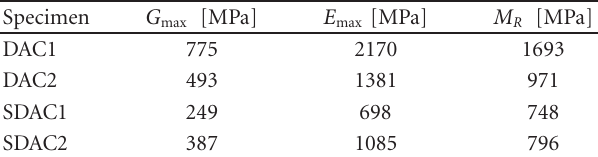
Table 2: Shear, elastic, and resilient modulli of di ff erent